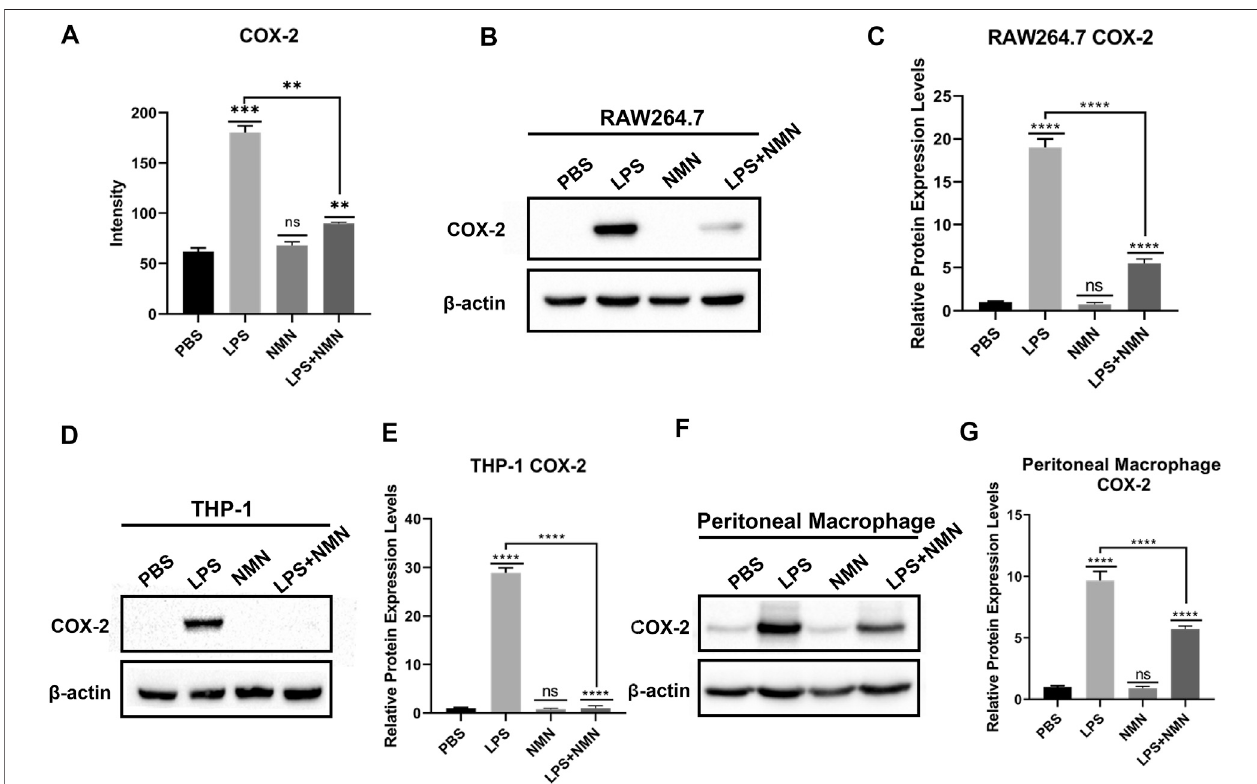
FIGURE5| NMNdecreasedcellularCOX-2expressioninRAW264.7cells,THP-1cellsandmouseperitonealmacrophages. (A) COX-2levelsfromtheproteomics data. (B,C) COX-2 expression in RAW264.7 cells was analyzed by western blotting. (D,E) COX-2 expression in THP-1 cells was analyzed by western blotting. (F,G) COX-2 expression in peritoneal macrophages was analyzed by western-blotting. The experiment was performed in triplicates and repeated three times. P values were calculated using one way ANOVA test. **** p < 0.0001, ** p < 0.01, * p < 0.05; mean ± SEM.